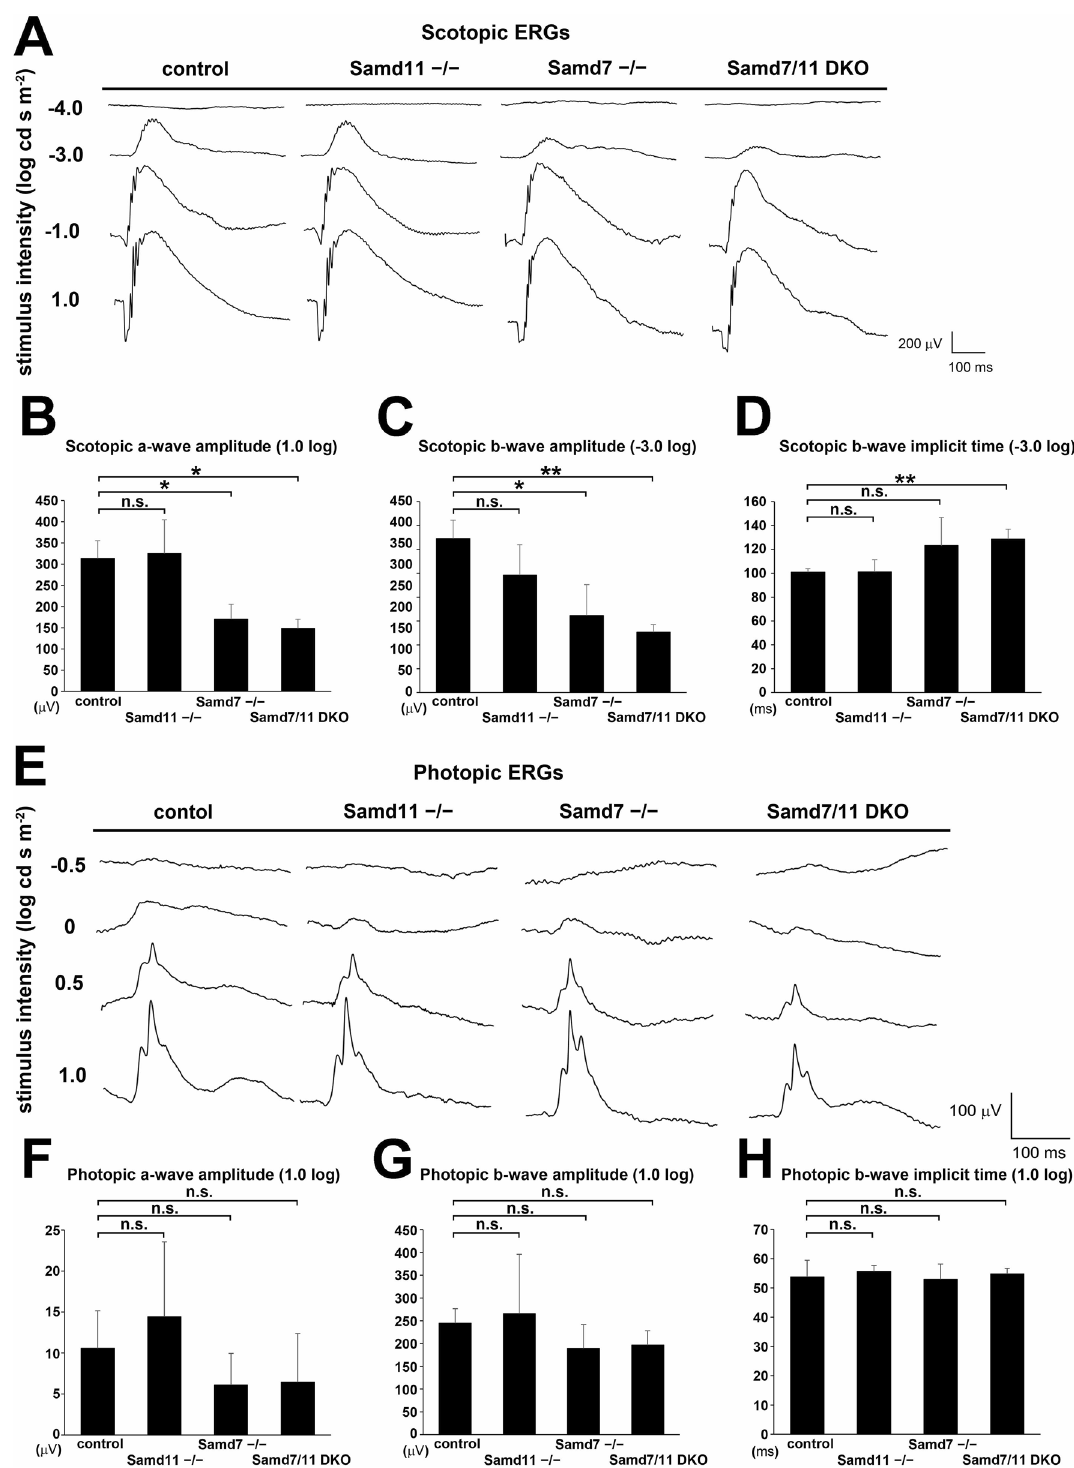
Figure 3. ERG analysis of Samd11 −/− and Samd7/11 DKO mice. (A) Representative scotopic ERGs recorded from 2 M control, Samd11 −/− , Samd7 −/− , and Samd7/11 DKO mice under a range of white light. (B) The mean scotopic ERG a-wave amplitudes. The Samd7 −/− , and Samd7/11 DKO mice showed reduced amplitudes at 1.0 log cd sm -2 . (C) The mean scotopic ERG b-wave amplitudes. The Samd7 −/− , and Samd7/11 DKO mice showed reduced amplitudes at − 3.0 log cd sm −2 . (D) The implicit time of the scotopic ERG b-wave was prolonged in the Samd7/11 DKO mice at − 3.0 log cd sm −2 . ( E ) Representative photopic ERGs recorded from 2 M control, Samd11 −/− , Samd7 −/− , and Samd7/11 DKO mice under a range of white light. (F) The mean photopic ERG a-wave amplitudes elicited by 1.0 log cd-s/m 2 white- light stimuli. (G) The mean photopic ERG b-wave amplitudes elicited by 1.0 log cd-s/m 2 white-light stimuli. (H) The implicit time of the photopic ERG b-wave elicited by 1.0 log cd-s/m 2 white-light stimuli. Error bars indicate mean ± SD, n = 3 per group. Student’s t-test; ** P < 0.01, * P < 0.05, n.s. not